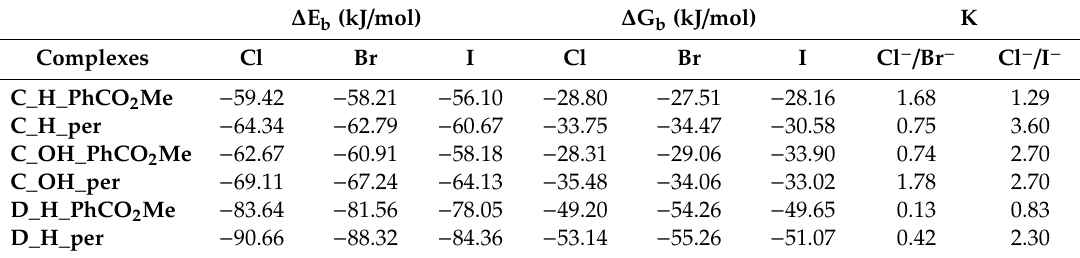
Table 6. Binding energies (E b ) and binding free energy ( ∆ G b, at 298K) (kJ / mol) upon complexation at m062x / aug–cc–pVTZ computational level. Equilibrium constants for the halogen-bonding interaction. ∆ E / mol) ∆ G / mol) K b (kJ b (kJ Complexes